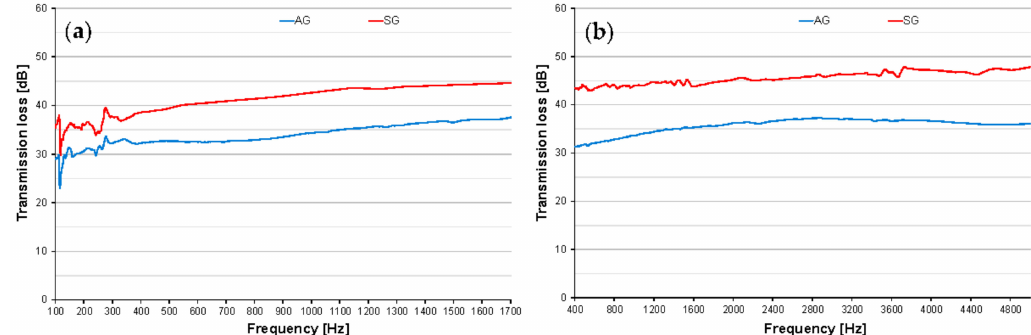
Figure 11. Normal incidence Transmission Loss of AG and SG samples: ( a ) large tube and ( b ) small